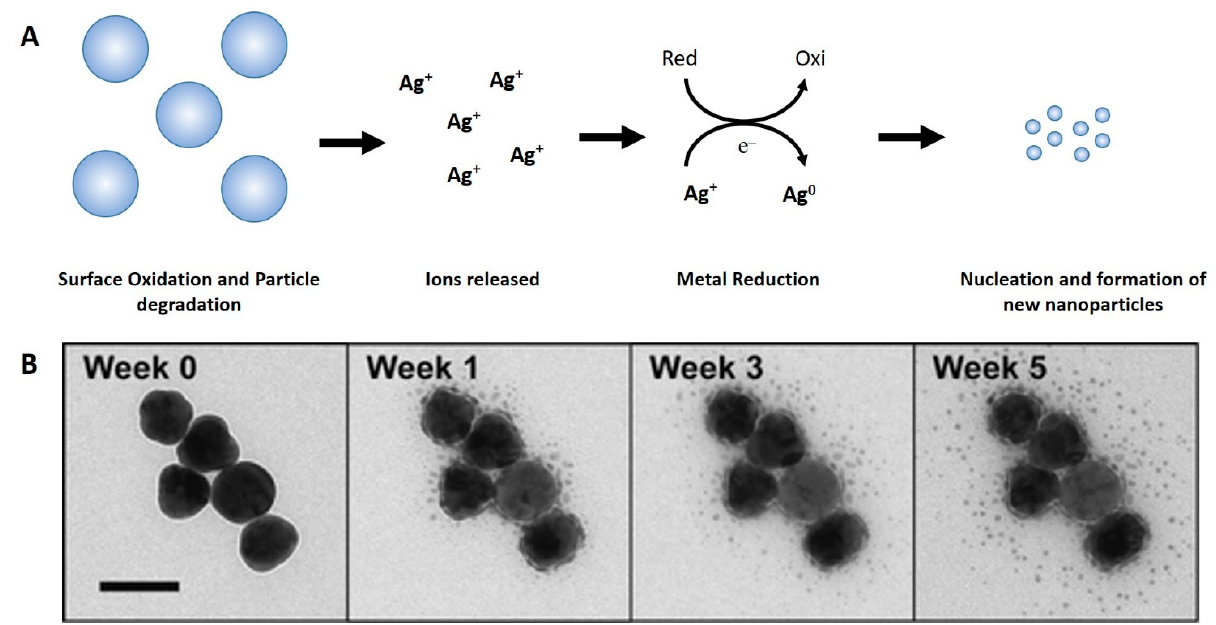
Figure 4. ( A ) Proposed pathway for new particle formation by the dissolution process of the parentals. First, surface oxidation occurs with ambient oxygen and water. Ionized silver diffuses away from the parent particle in the water layer driven by the concentration gradient. New particle formation by nucleation via the chemical and/or photochemical reduction of silver ions. ( B ) Formation of small NPs in the vicinity of 75 nm AgNPs at 100% relative humidity over five weeks. TEM images during the exposure period show increasing numbers of small NPs throughout this period (Glover, Miller and Hutchison, 2011). Reprinted with permission from Glover, Miller and Hutchison, (2011). Copyright © 2011, American Chemical Society.